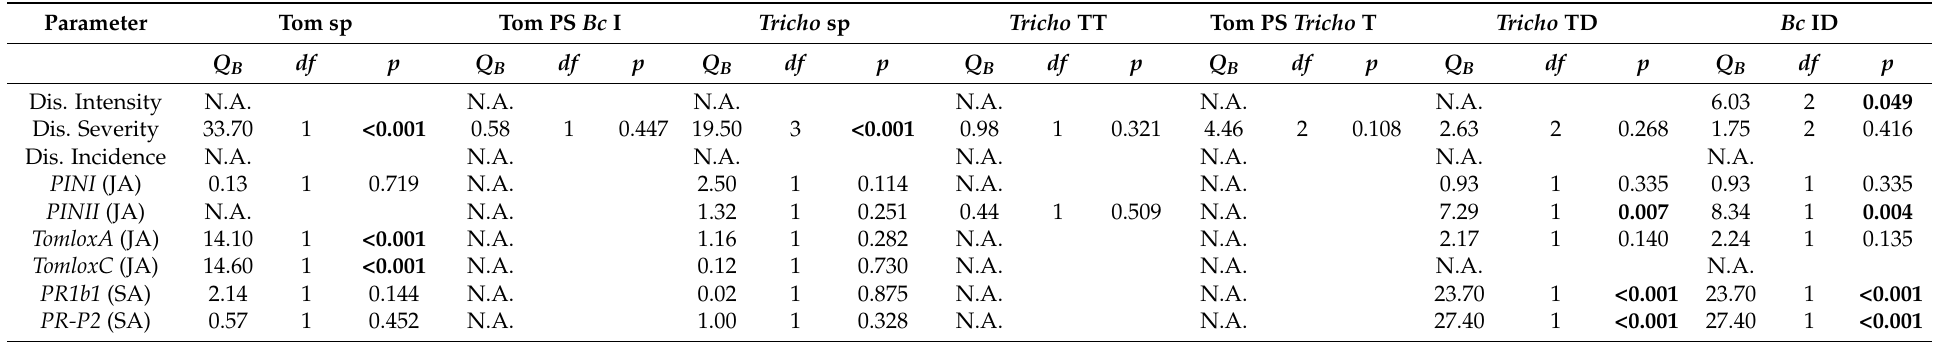
Table 1. Between-group heterogeneity ( Q B ), degrees of freedom ( df ) and p -value ( p ) for the effect size of Trichoderma on Botrytis cinerea infection (i.e., disease intensity, severity and incidence) and defense-related genes involved in jasmonic (JA; i.e., proteinase inhibitors I and II, PINI and PINII , and tomato lipoxygenase A and C, TomloxA and TomloxC ) and salycilic acid (SA; pathogenesis-related 1b1 and P2, PR1b1 and PR-P2 ) pathways in tomato, across descriptive categories (tomato